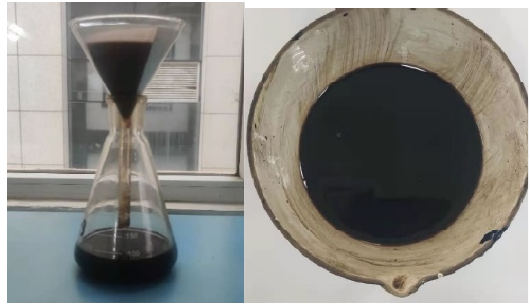
Figure 1. Filter waste engine oil device. Table 2. Composition of waste engine